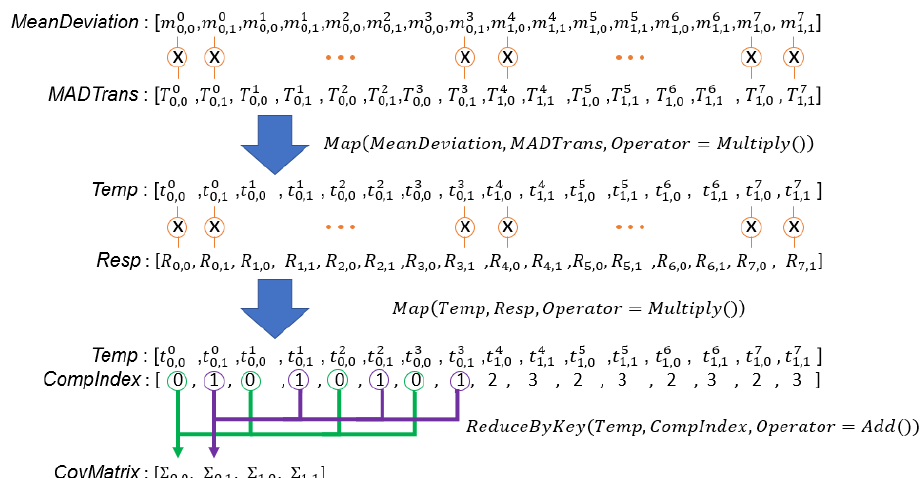
Figure 11. Illustration of computation of covariance matrices of all sets. m k a 1 by n vector, t k is an n by n matrix, and R i , j is a scalar i , j